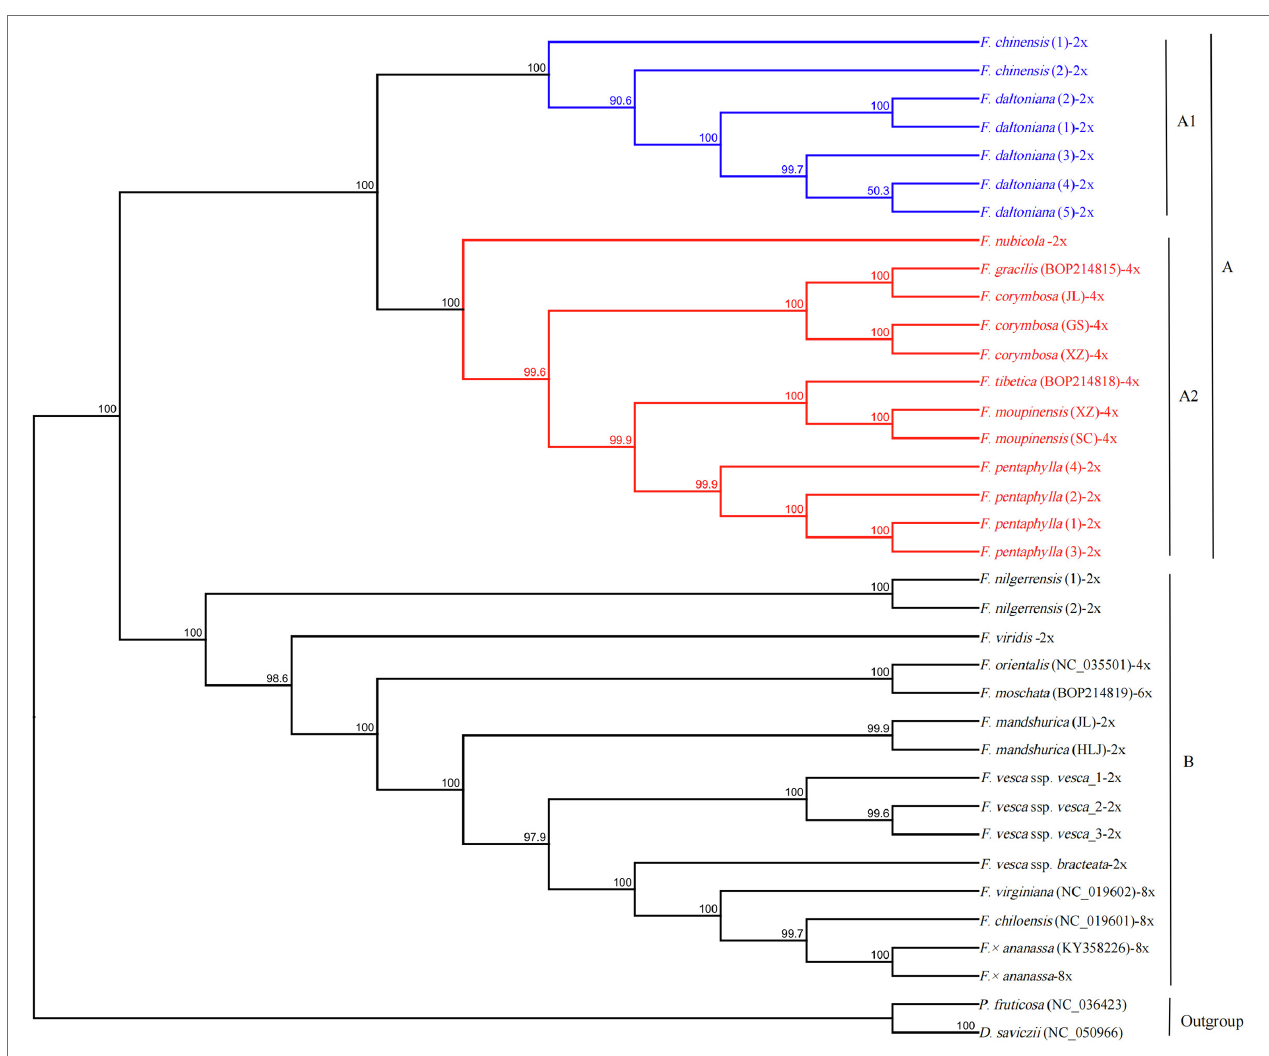
FIGURE 5 | A maximum likelihood phylogenetic tree was reconstructed based on 34 Fragaria cp genomes. Potentilla fruticosa and Drymocallis saviczii were used as outgroups, and − 2x, − 4x, and − 8x represent the different ploidies of Fragaria spp. Nodes marked with capital letters are discussed in the